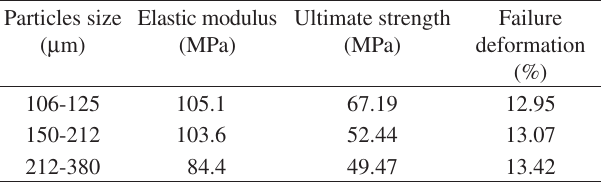
Table 2. Average mechanical properties of the HDPE specimens prepared with different particles size.